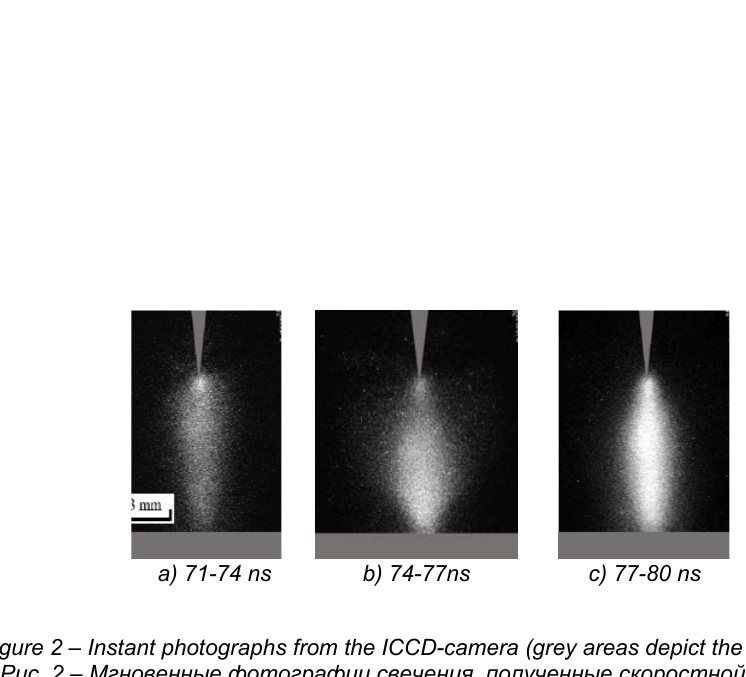
Figure 2 – Instant photographs from the ICCD-camera (grey areas depict the electrodes) Рис . 2 – Мгновенные фотографии свечения , полученные скоростной